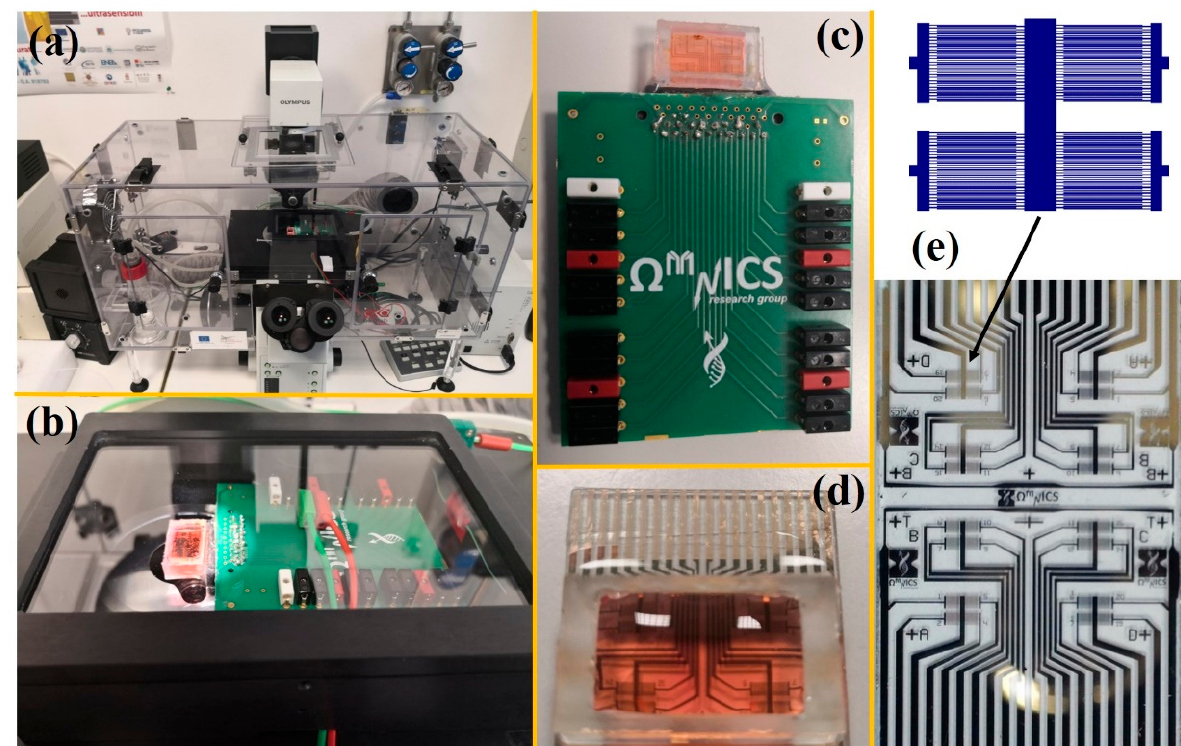
Figure 1. ( a ) Experimental setup employed for on-chip ECIS cell proliferation assays, including a LCR meter for impedance measurements and an inverted optical microscope with a controlled environment chamber for maintaining appropriate values of relative humidity, CO 2 , and temperature. ( b ) Detail of the incubation chamber containing ( c – e ) the chip and its interfacing PCB; each interdigitated microelectrode sensor with 10 µm finger/space pitch features covers a 1 × 1 mm area on the chip.